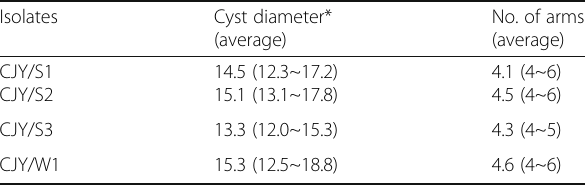
Table 1 Morphological feature of Acanthamoeba isolates analyzed in this study Isolates Cyst diameter* (average)